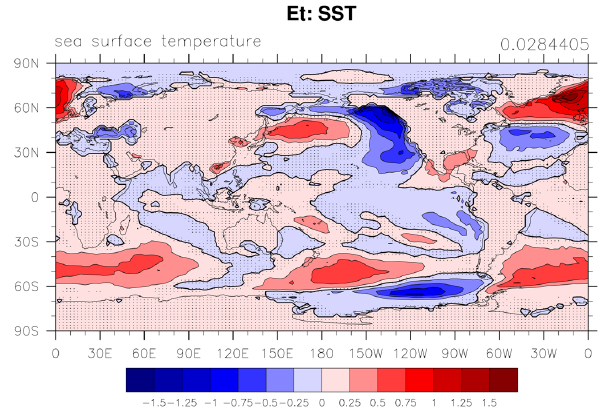
Fig. 3. The change in SST between SOM_c and SOM_nc experi- ment. The dotted areas are changes that are not statistically signifi- cant at the 95% confidence